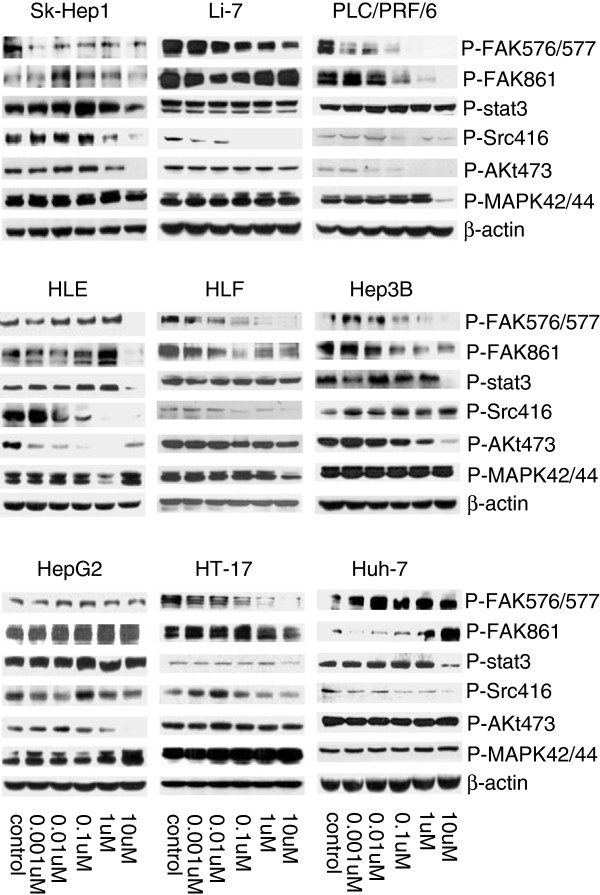
The effect of dasatinib in cell signalling. Western blot analysis with phosphorylated Src, FAK, Stat3, Akt and MAPK in HCC cell lines after 24 hours treatment of dasatinib. The cell lines were arranged according to their IC50 to dasatinib. The top three were most sensitive, the bottom 3 were least sensitive.